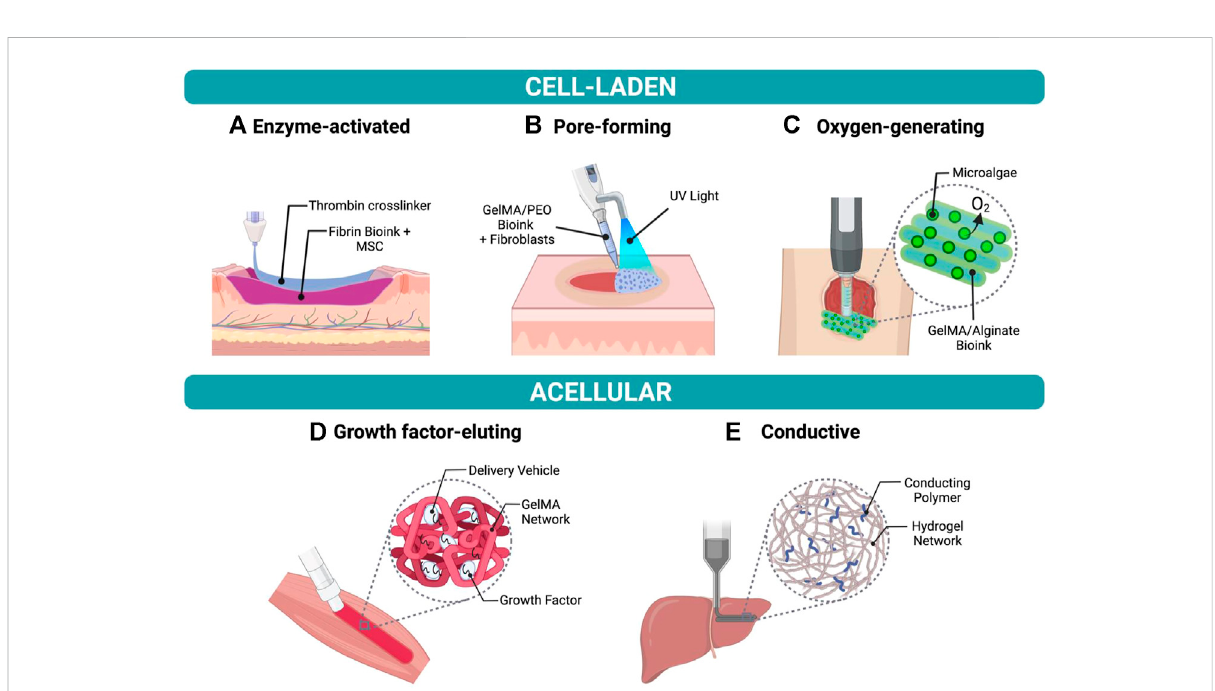
FIGURE 2 Examples of bioinks for in situ bioprinting (A) Fibrin-based bioink with mesenchymal stem cells (MSCs) crosslinked using thrombin to form a hydrogelinaskinwoundbed. (B) Fibroblast-ladenbioinkcomposedofgelatinmethacrylate(GelMA)andpolyethyleneoxide(PEO)photocrosslinked using UV light to create a porous scaffold. (C) GelMA and alginate bioink containing oxygen-producing microalgae to treat chronic wounds. (D) Growthfactor-elutingbioinkappliedtomuscleinjurytopromotefunctionalmusclerecovery. (E) Conductivehydrogelcomposedofhyaluronic acid and pluronic-F-127 printed onto